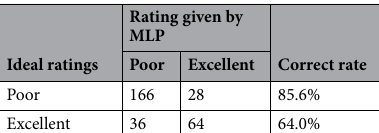
Table 5. Multi-layer perceptron neural network training correctness results.